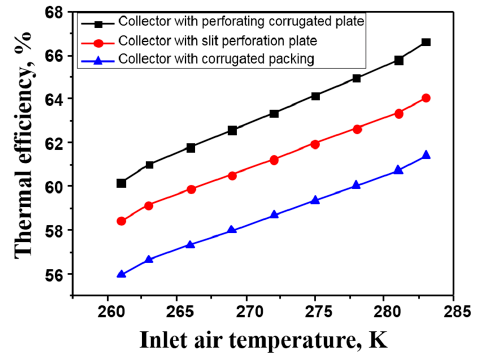
Figure 7. Effects of inlet air temperature on the thermal